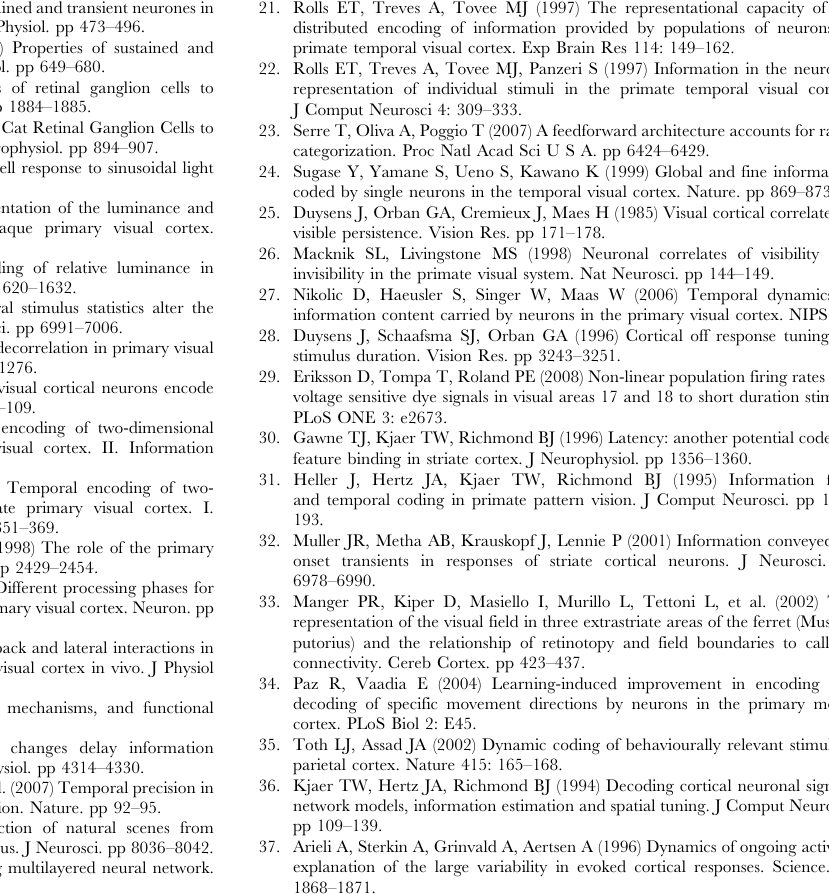
Figure S8 The decoded pattern depends on the global luminance change. A: The luminance difference for all possible pattern transitions. The decoding was done for pattern transitions with luminance differences between 0–9 cd/m2 (B), 9–18 (C), 18– 60 (D). Note that the correlation with the current pattern at 50 ms was decreased for large luminance differences (D). Found at: doi:10.1371/journal.pone.0010327.s008 (0.67 MB TIF) Movie S1 Encoded image sequence in response to a clip from the original trailer of Australia TM . Found at: doi:10.1371/journal.pone.0010327.s009 (1.81 MB MPG) Text S1 Found at: doi:10.1371/journal.pone.0010327.s010 (0.05 MB